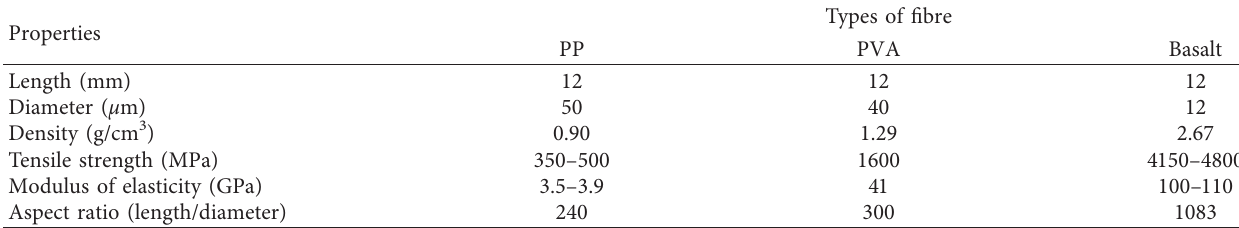
Table 1: Properties of fibres.